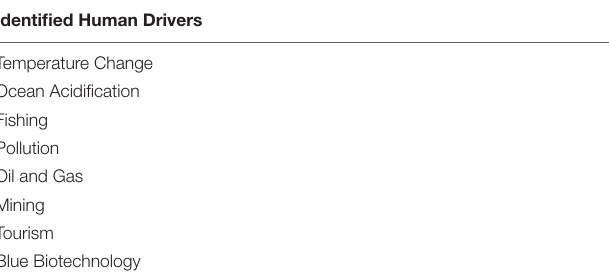
TABLE 2 | Human drivers identified for the Delphi survey risk assessment.